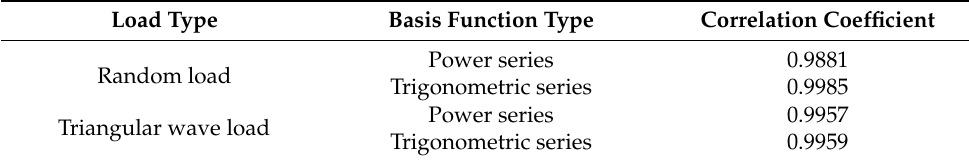
Table 2. Noise-free load identification and real correlation coefficients.